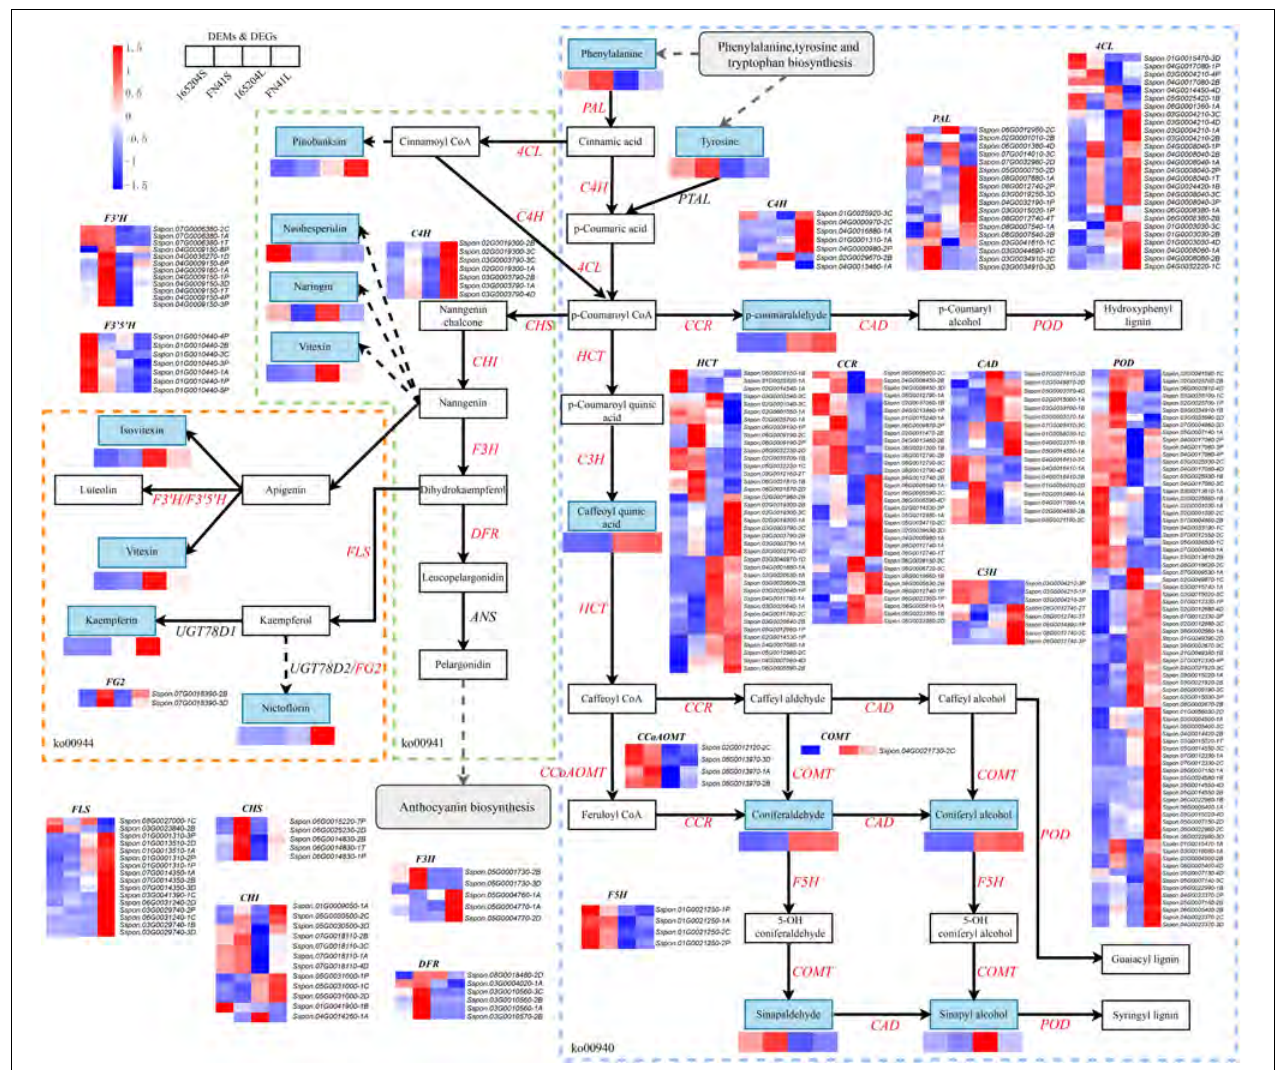
FIGURE 8 | Diagram of phenylpropanoid and flavonoid biosynthesis pathways with their related DEGs and DEMs. PAL, phenylalanine ammonia lyase; PTAL, phenylalanine/tyrosine ammonia-lyase; C4H, cinnamate4-hydroxylase; 4CL, 4-coumarate CoA ligase; HCT, hydroxycinnamoyl CoA shikimate/quinate hydroxycinnamoyl transferase; C3H, P-coumarate 3-hydroxylase; COMT, caffeic acid O -methyltransferase; CCoAOMT, caffeoyl-CoA O -methyltransferase; CHI, chalcone isomerase; CCR, cinnamoyl-CoA reductase; CAD, cinnamyl alcohol dehydrogenase; F5H, ferulate5-hydroxylase; F3 (cid:48) 5 (cid:48) H, flavonoid 3 (cid:48) ,5 (cid:48) -hydroxylase; POD, peroxidase; FLS, flavonol synthase; DFR, dihydroflavonol 4-reductase; Non-significant DEGs are shown in black. The solid line indicates the metabolic reactions in only one step. The dash line presents more than one step of the metabolic